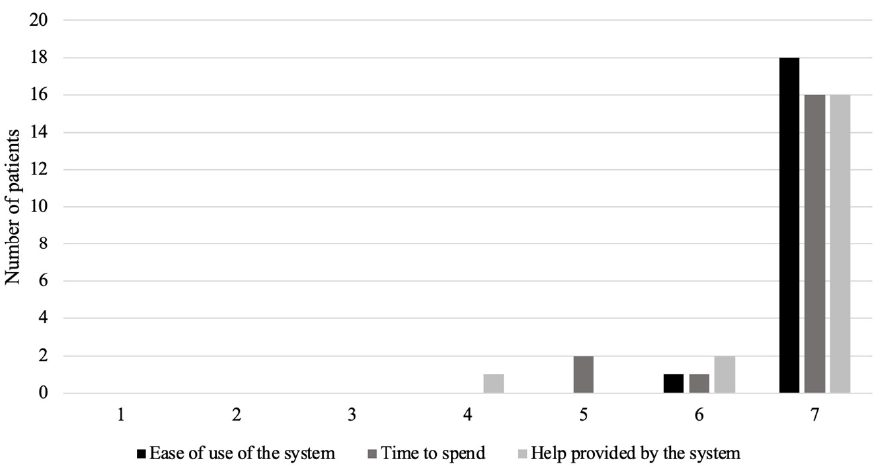
Figure 11. Satisfaction with Spirobank Smart ® follow-up according to the ASQ (After Scenario Questionnaire) after 3 months of use. Each items is rated from 1 (not satisfied) to 7 (very satisfied).